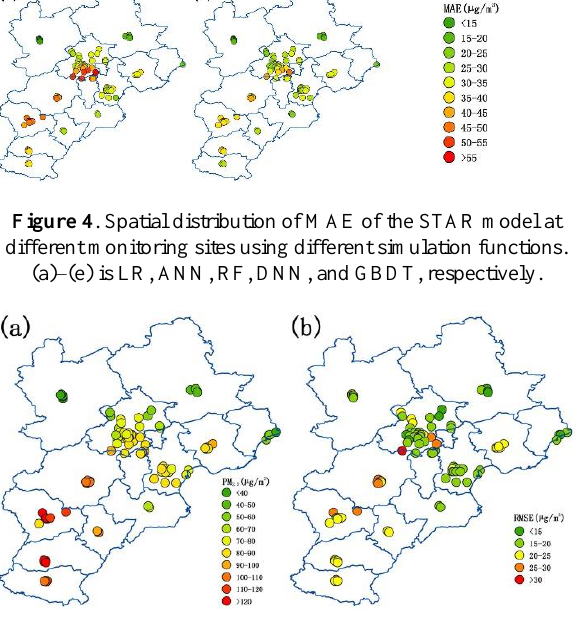
Figure 5 . (a) PM2.5 annual average concentration of the monitoring sites in JingJinJi in 2014; (b) PM2.5 inversion performance statistics of each monitoring